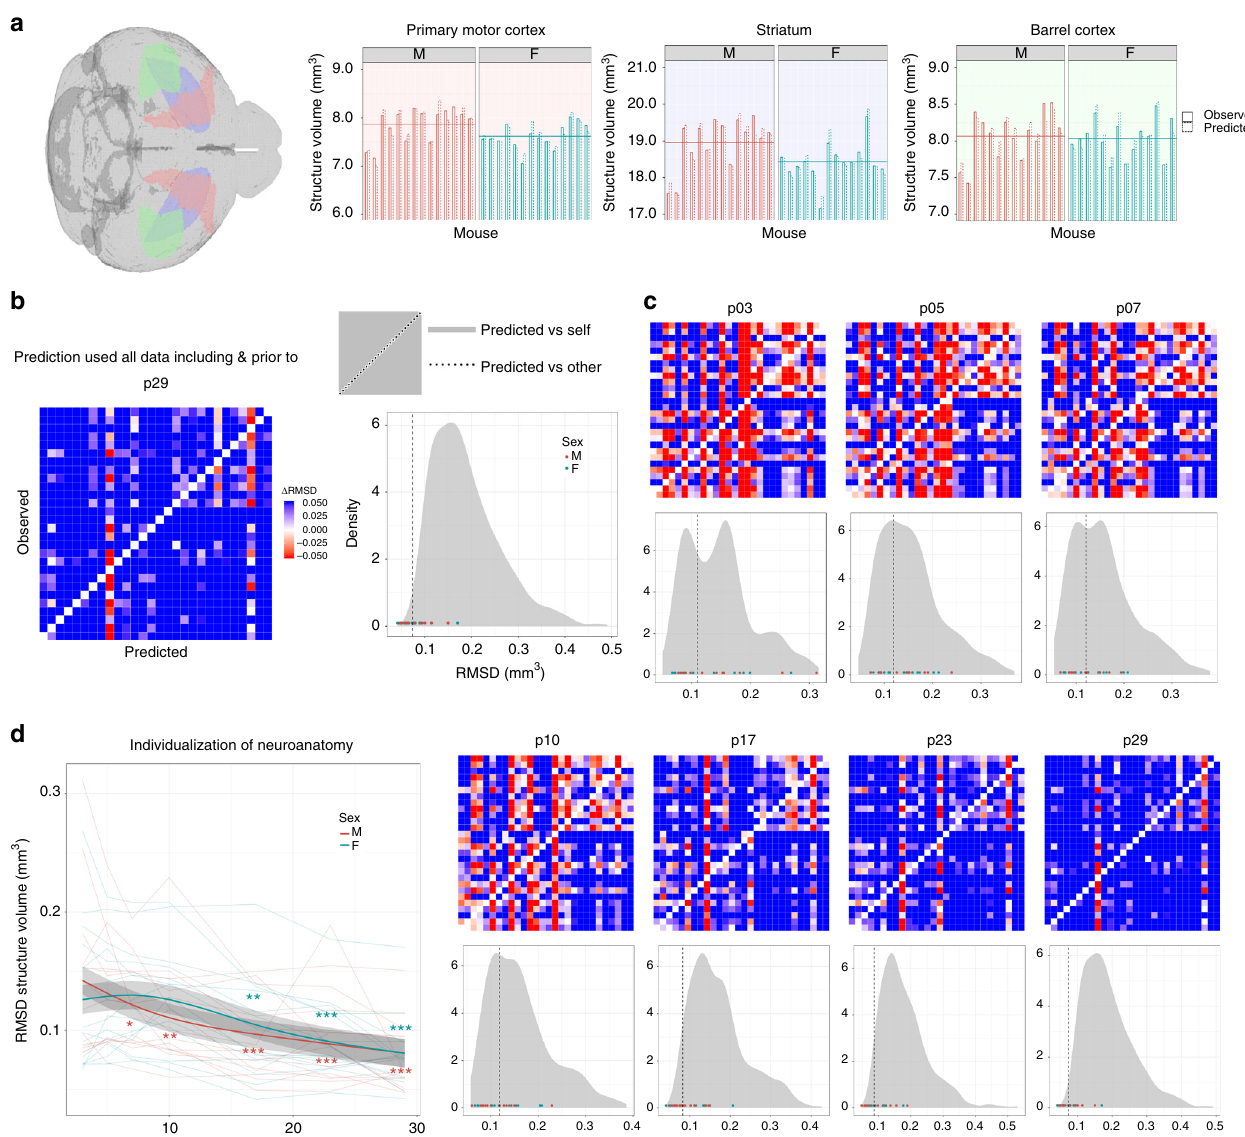
Fig. 8 Prediction and individualization of neuroanatomical structure volumes. a Predicted and Observed p36 structure volumes for all subjects and three representative structures: primary motor cortex, striatum, and the barrel cortex. When predicting any subject at p36, the model was trained on all data excluding the predicted subject at p36 and all subjects at p65. Despite this exclusion, the model uses neuroanatomical information from earlier time points to predict structure volumes ’ variation from the average (horizontal line). b Matrix plotting the root-mean-square-difference (RMSD) between the observed structure volumes (rows) and the predicted structure volumes (columns) for each subject at p36. Prediction used all data prior to and including p29. Each column (Subject X prediction) was centered so that the diagonal RMSD (observation vs prediction for Subject X) is 0. Blue or red off-diagonal cells (observation Subject Y vs prediction Subject X) indicate RMSD greater or less than diagonal entry. Density plot shows that diagonal RMSD elements (values as points and median as vertical line) tend to be less than off-diagonal RMSD (grey distribution), indicating high prediction speci fi city (One-sample Kolmogorov – Smirnov test: D þ ¼ 0 : 79894 ; P < 10 (cid:2) 15 ; n ¼ 28). c Models were trained on data closer to the time point of prediction (p36). For example, models corresponding to 'p10' were trained on p10 data and all earlier data (p3, p5, p7). As more data is included, model accuracy and speci fi city improved with signi fi cant speci fi city at p10 and above (One-sample Kolmogorov – Smirnov test: D þ ¼ 0 : 34392 ; P ¼ 0 : 001 ; n ¼ 28). d Prediction accuracy (RMSD) at p36 for each subject tends to improve over the course of neurodevelopment. When x -axis = X , subject data from ages ≤ X were used in the prediction. Trendlines denote patterns seen by sex and there is no signi fi cant difference in prediction accuracy between the sexes at any time (with shaded regions denoting standard error). Improvement in prediction accuracy (* P <0.05, ** P <0.01, *** P <0.001) indicates neuroanatomy individualization, which occurs signi fi cantly earlier in males (permutation test, P =